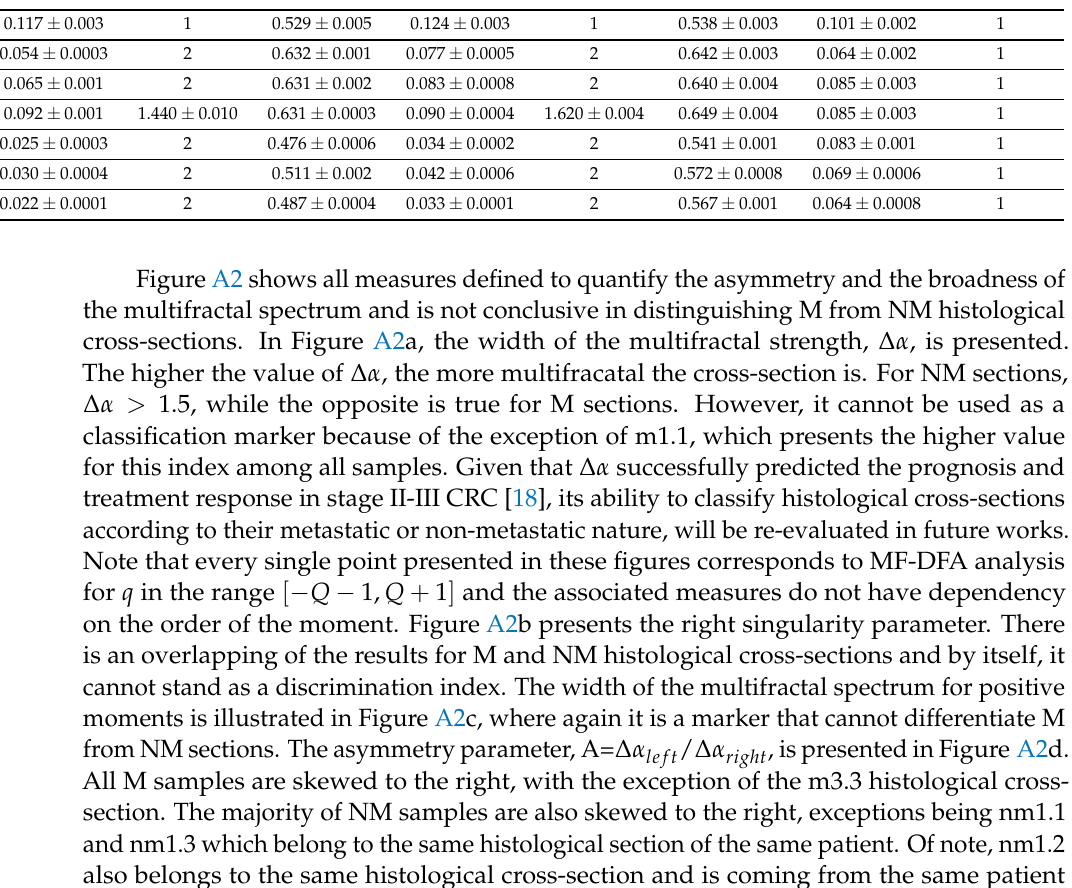
Table A1. The generalized Hurst exponent H , the co-dimension information C and the multifractality index α L of the structure function scaling exponent, z ( q ) . Note that α L is not associated with an error when the best fit either obtained by z ( q ) = Hq